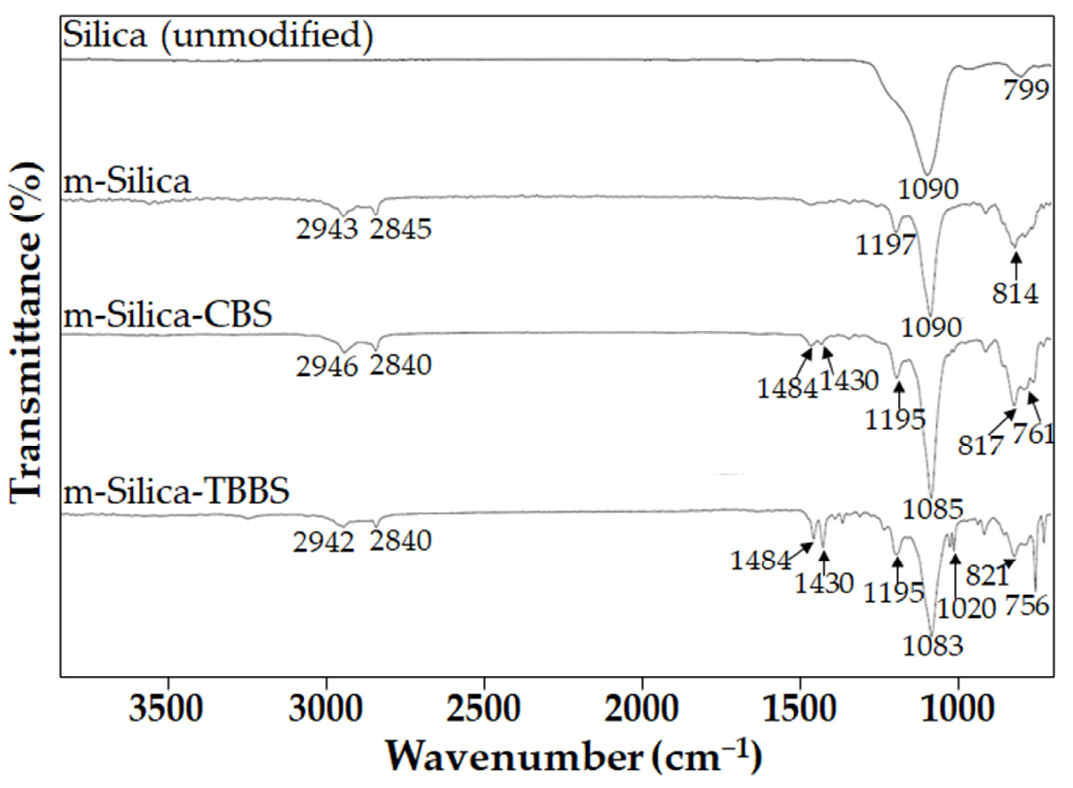
Figure 3. FTIR spectra of silica (unmodified), m-silica, m-silica-CBS, and m-silica-TBBS. Table 2. FTIR peak assignments of silica (unmodified), m-silica, m-silica-CBS, and m-silica-TBBS. FTIR Peak (cm − 1 )